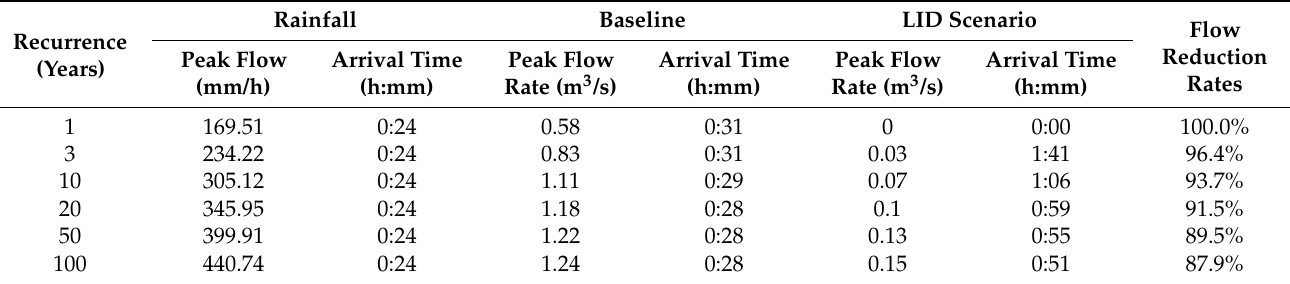
Table 7. Peak flows of the pipe at the